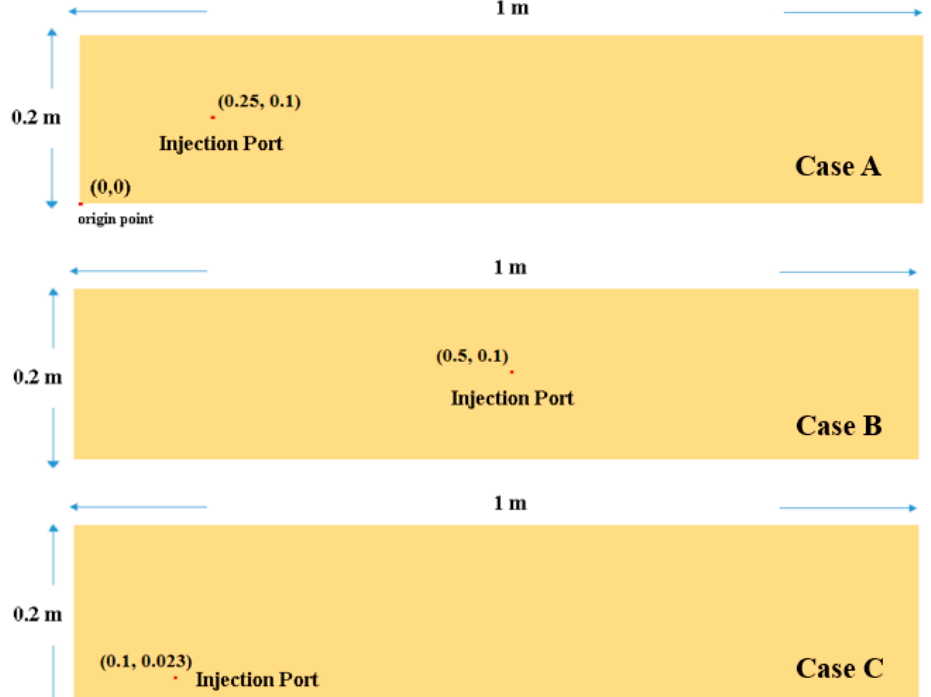
Figure 1. Selected cases with different injection port positions: case A ( top picture ), case B ( middle picture ) and case C ( bottom picture ). The coordinates of the points are given in meters with respect to the origin point.